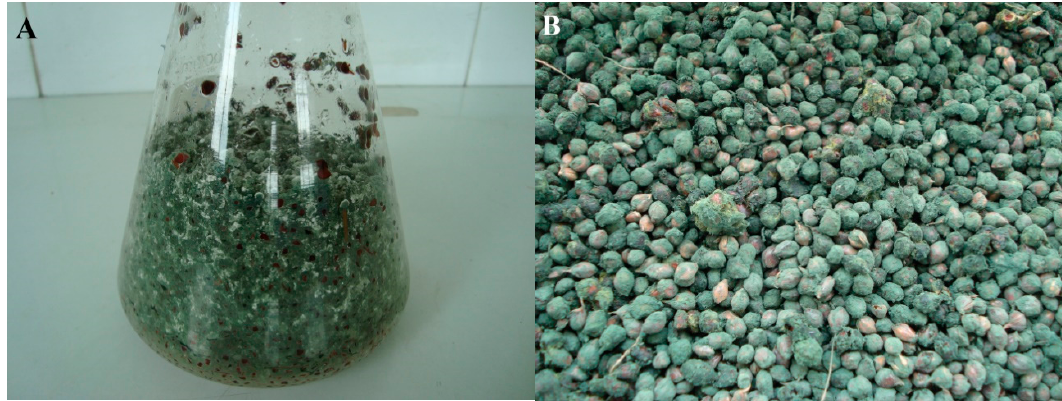
Figure 1. Solid state fermentation of T. harzianum AS12-2 strain on broom sorghum grains. ( A ) Fermentation flask. ( B ) Grains colonized by T. harzianum after